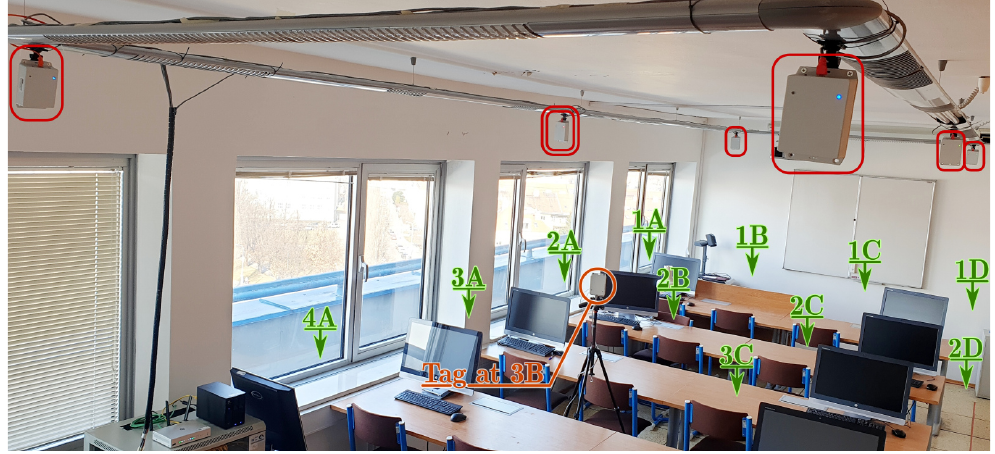
Figure 5. Testbed photography; anchors are highlighted by red rectangles (master anchor by double rectangle); visible test locations marked by green arrows; tag is highlighted by orange